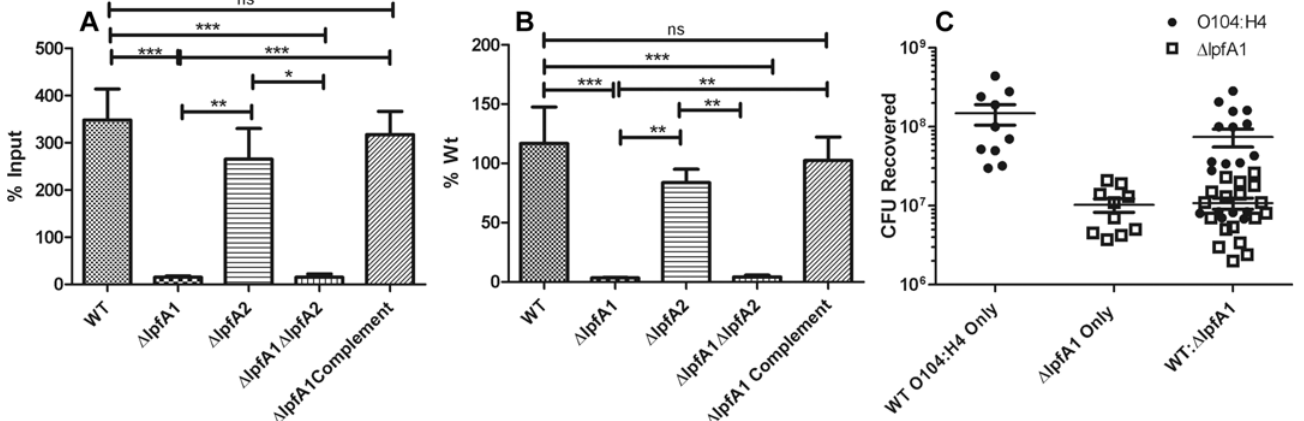
Fig 2. Effect of lpf1 and lpf2 mutants on adhesion of E . coli O104:H4 to differentiated intestinal epithelium. E . coli O104:H4, Δ lpfA1 , Δ lpfA2 , Δ l pfA1 Δ lpfA2 , and Δ l pfA1 complemented strains ’ adhesion was measured in non-polarized Caco-2 cells. All experiments where done with an MOI of 100 and bacteria was recovered and quantified at 3 h post-infection. Results are expressed as (A) percent input and (B) input compared to the wild type strain. Competition of wild type and Δ lpfA1 was done in the same way and seen in (C) as input of CFUs recovered. Error bars indicated SEM of 3 independent experiments each performed with triplicate